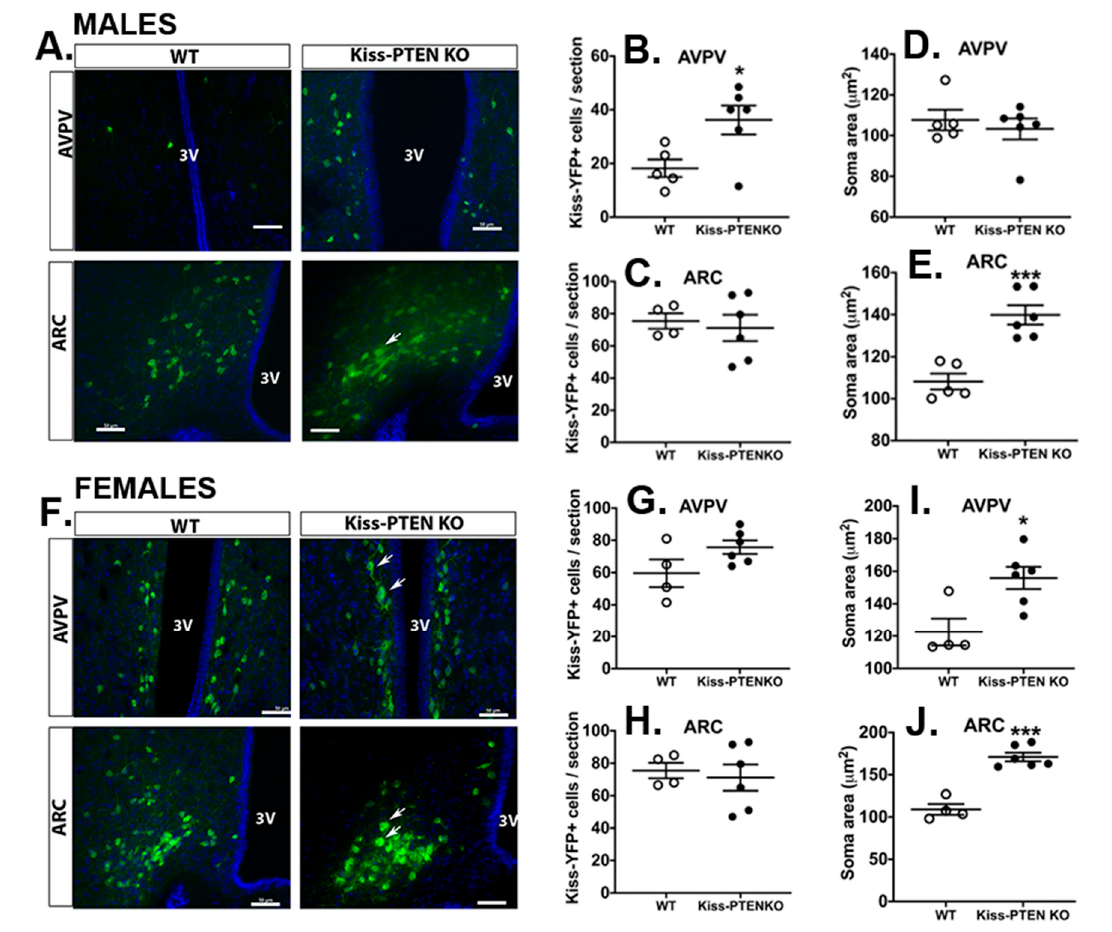
Figure 5. Sex and region-specific kisspeptin neuron hypertrophy in Kiss-PTEN KO mice. ( A ) Representative immunofluorescent images show higher number of Kiss-GFP + neurons in the AVPV as well as increased fiber staining and larger cell bodies in the ARC (white arrow) of Kiss-PTEN KO males. 3V, third ventricle. Scale bars, 50 µ m. ( B , C ) Quantification of Kiss-GFP + cells in the AVPV and ARC of males. ( D , E ) Kisspeptin cell soma area measurement in the AVPV and ARC areas in males ( n = 5–6 / genotype). ( F ) Representative immunofluorescent images show larger Kiss-GFP + neurons in the AVPV and ARC of Kiss-PTEN KO females (white arrow). 3V, third ventricle. Scale bars, 50 µ m. ( G , H ) Quantification of Kiss-GFP + cells in the AVPV and ARC of WT and Kiss-PTEN KO females. ( I , J ) Kisspeptin cell soma area measurement in both AVPV and ARC ( n = 4–6 / genotype). Values are means ± SEM. Unpaired t-test, * p < 0.05, *** p < 0.001.